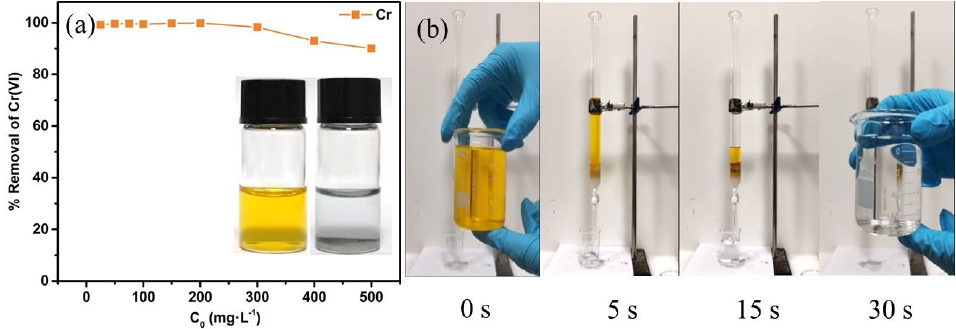
Figure 3. ( a ) Influence of the initial Cr (VI) concentration on the removal rate; ( b ) screenshot from the adsorption video (100 mL of Cr (VI) (500 mg/L − 1 ) solution passing through the column).